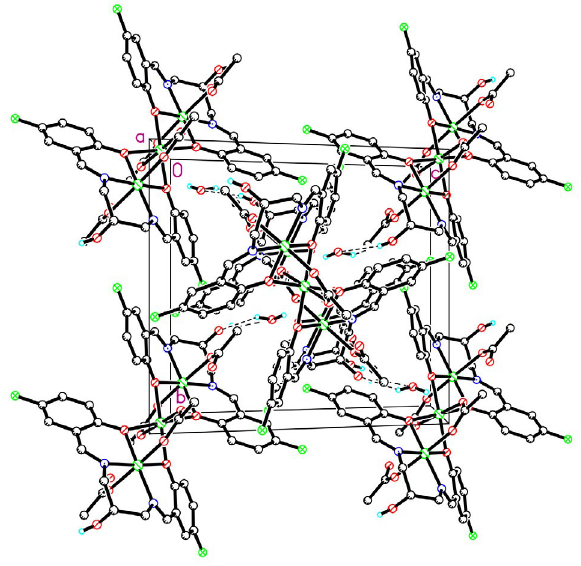
Fig. 4. Molecular packing diagram of the nickel complex, viewed along the a axis. Hydrogen bonds are drawn as dashed